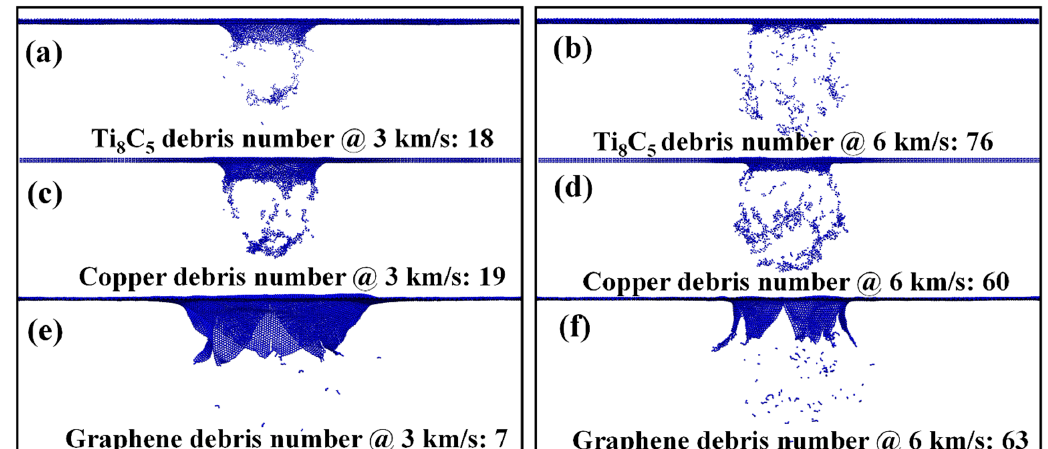
Figure 3. Impact deformation and discrete debris of nanosheets under various impact velocities. Amount of debris after impact for ( a , b ) Ti 8 C 5 , ( c , d ) Copper and ( e , f ) Graphene are presented, respec- tively.